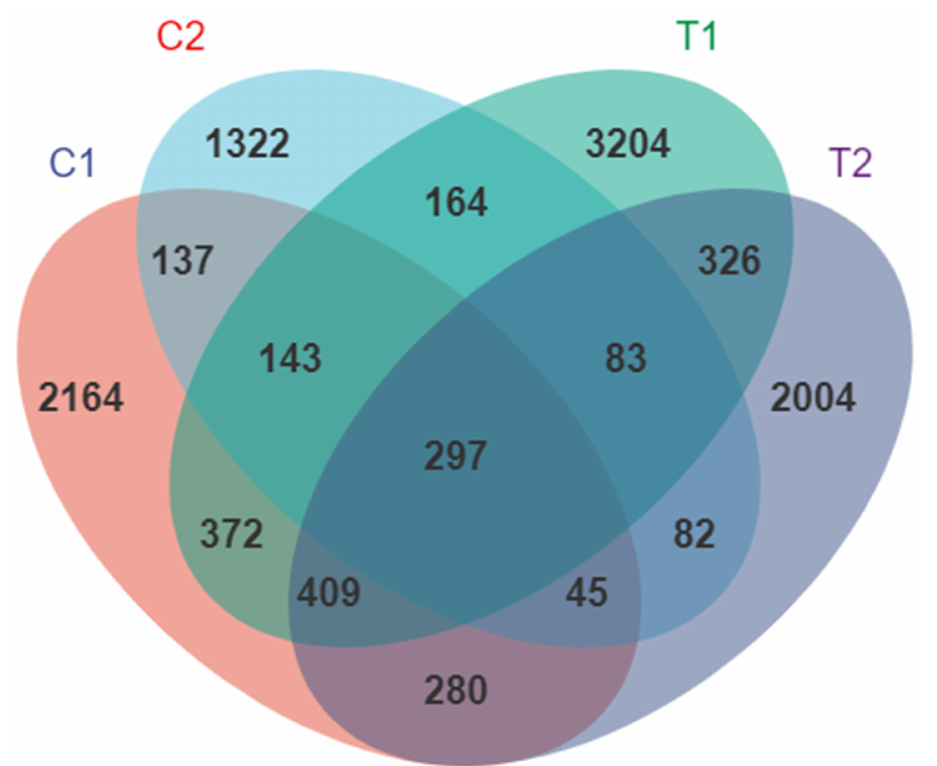
Figure 1. Venn diagram depicting the numbers of shared and unique amplicon sequence variants (ASVs) among Cipangopaludina cathayensis treatment groups C1 (control treatment; 25 ± 1 ◦ C, day 3), C2 (control treatment; 25 ± 1 ◦ C, day 7), T1 (high-temperature treatment; 32 ± 1 ◦ C, day 3), and T2 (high-temperature treatment; 32 ± 1 ◦ C, day